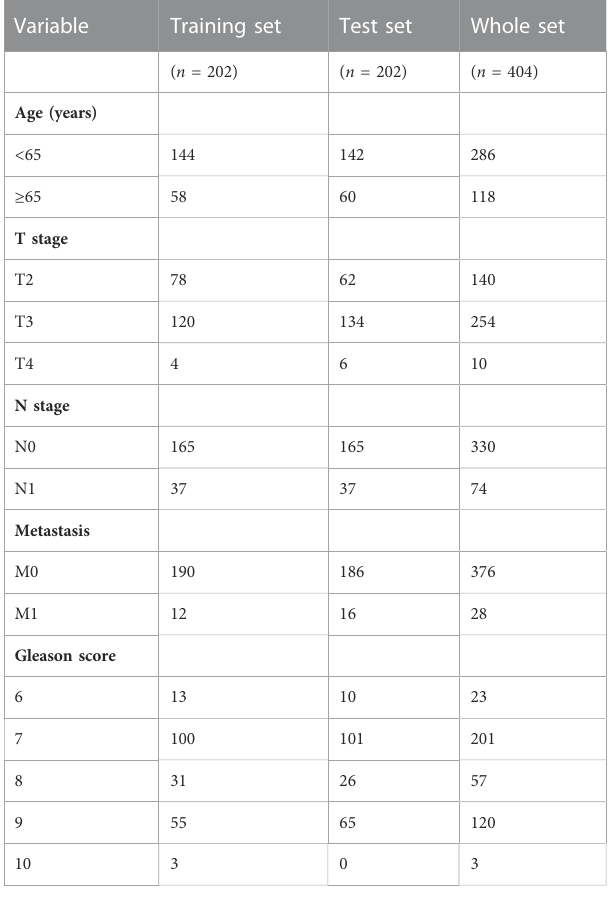
TABLE 1 Clinicopathologic features of 404 PCa patients from the TCGA